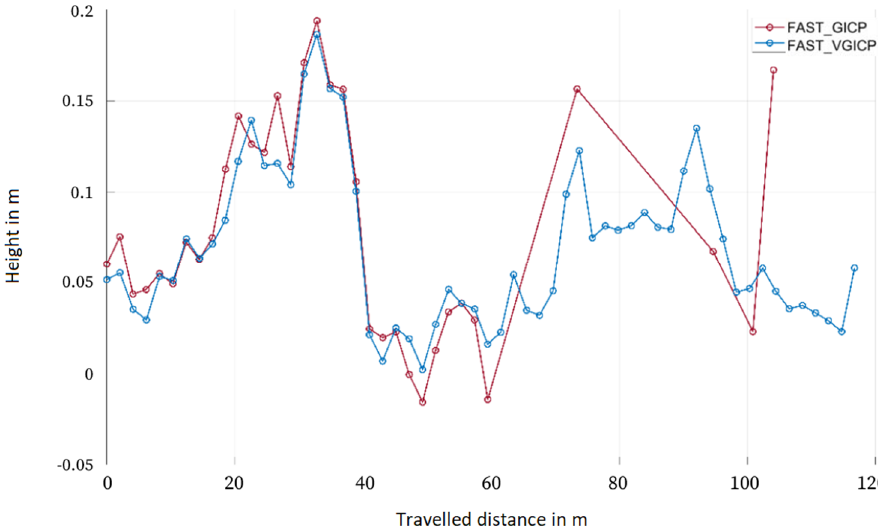
Figure 17. Height course of the trajectory determined by hdl_graph_slam with the activated floor_detection node.